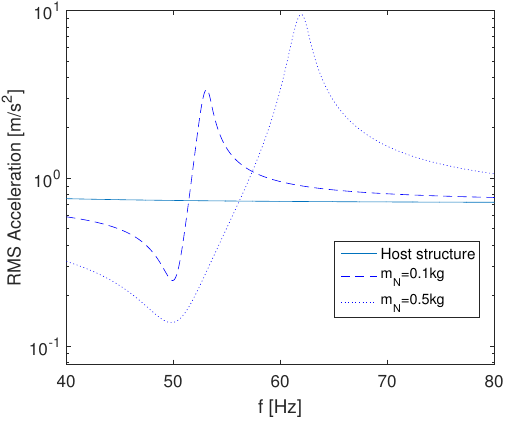
Figure 2. Vibration amplitude for a structure without and with neutralizers of different masses.